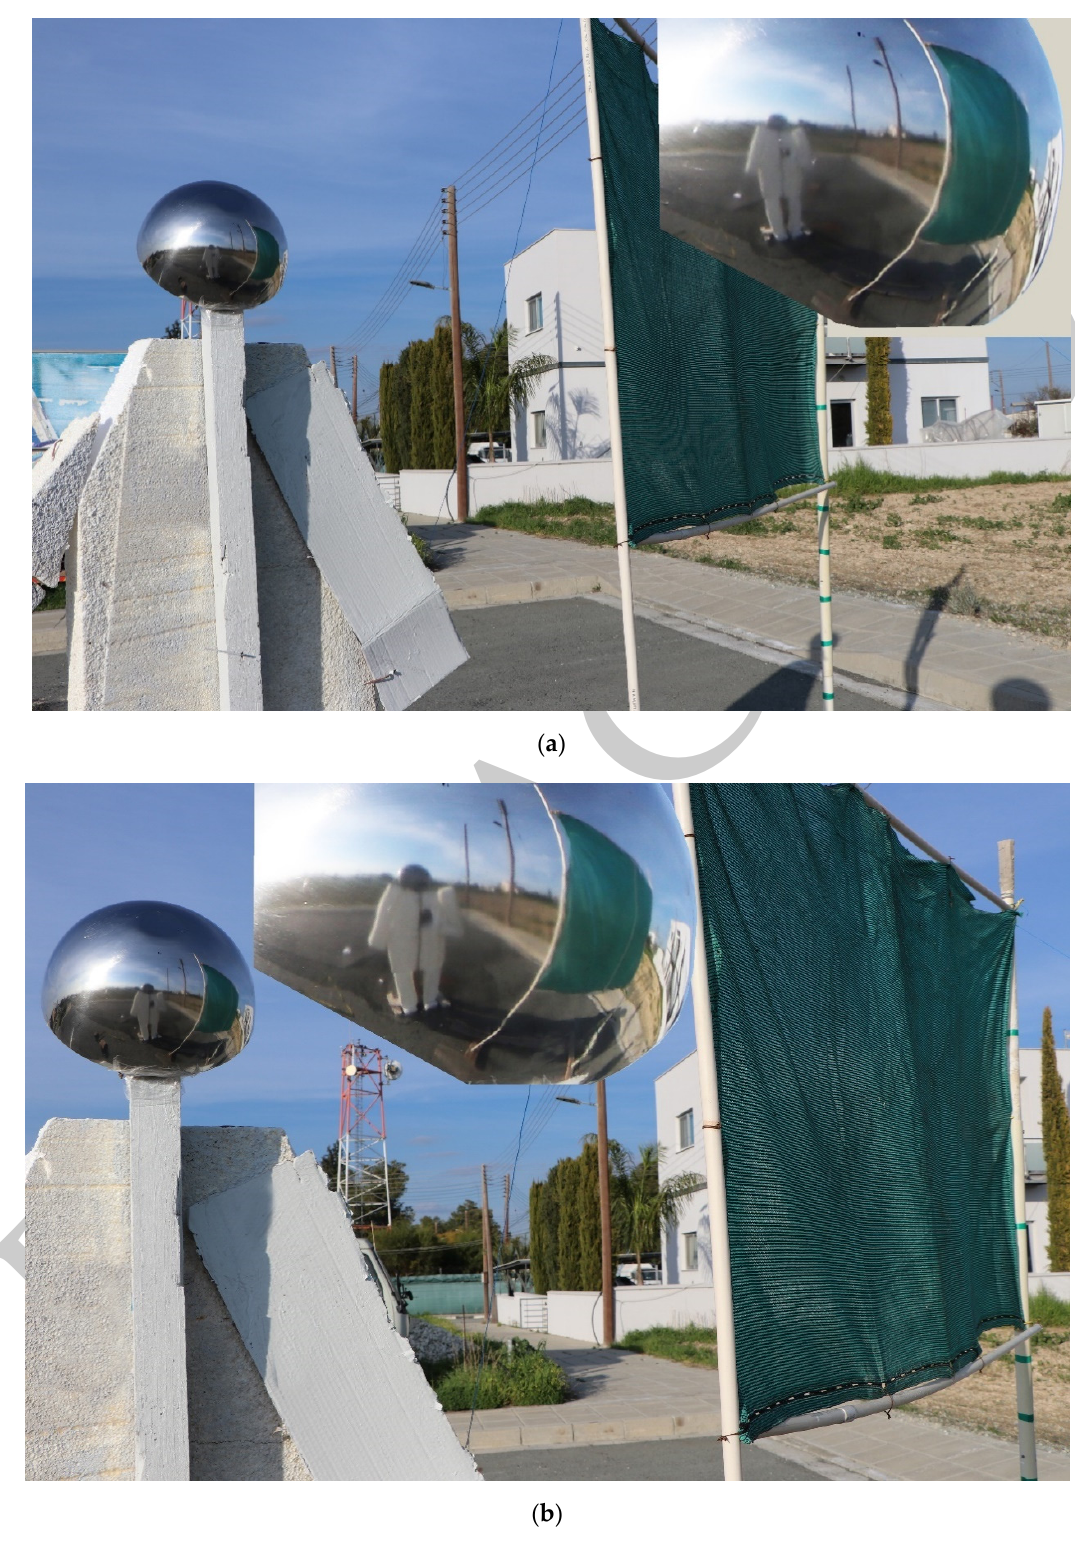
Figure 23. Reproduction: Photographer-astronaut standing near the line of capture indicated by the position of the Earth in the photo. The photographer’s shadow goes beyond the pole in the reflection of the helmet (see inset). Photographer is: ( a ) standing at a 1.8 m distance from the flag end along a line running parallel to the length of the flag and a distance of 0.5 m between the parallel lines; ( b ) standing at a 1.25 m distance from the flag end along a line running parallel to the length of the flag and a distance of 0.5 m between the parallel lines. For a topographic presentation of the exact points, see also Figure 25, point C for Figure 23a and point D for Figure 23b.